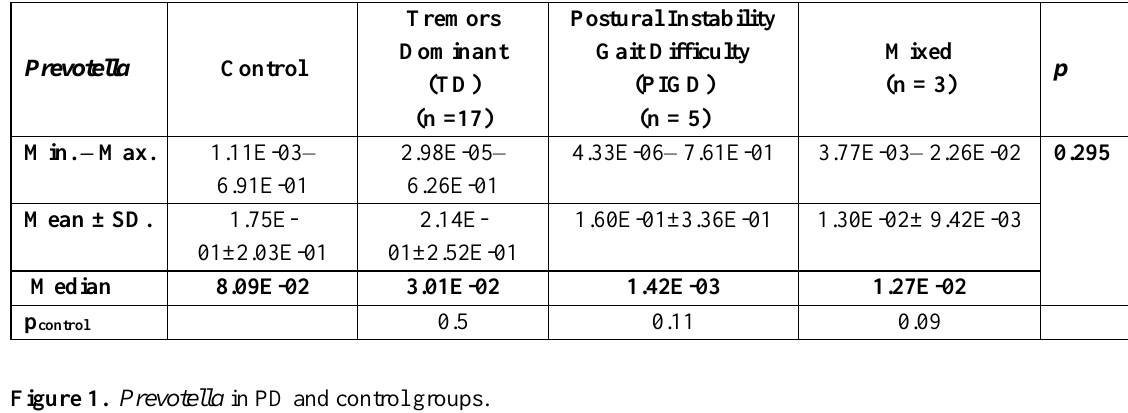
Table 5. Prevotella in PD phenotypes and control group.